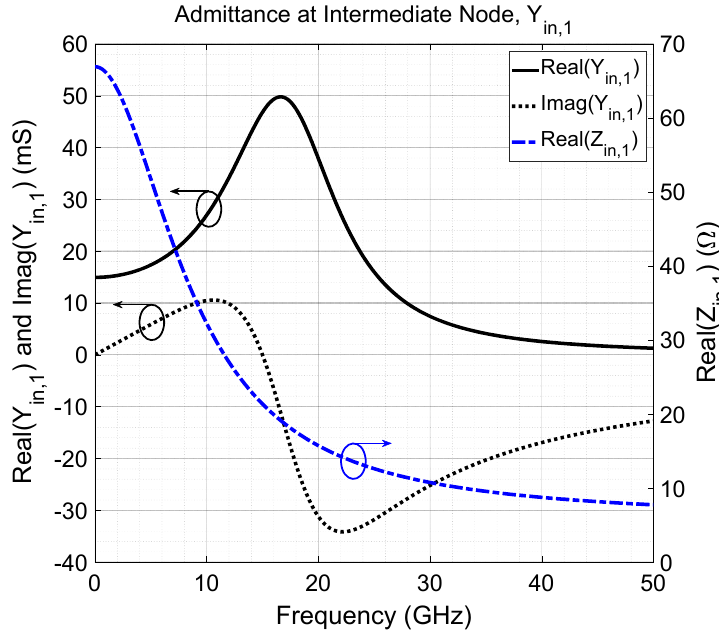
Figure 8. Admittance and resistance at intermediate node, Y in ,1